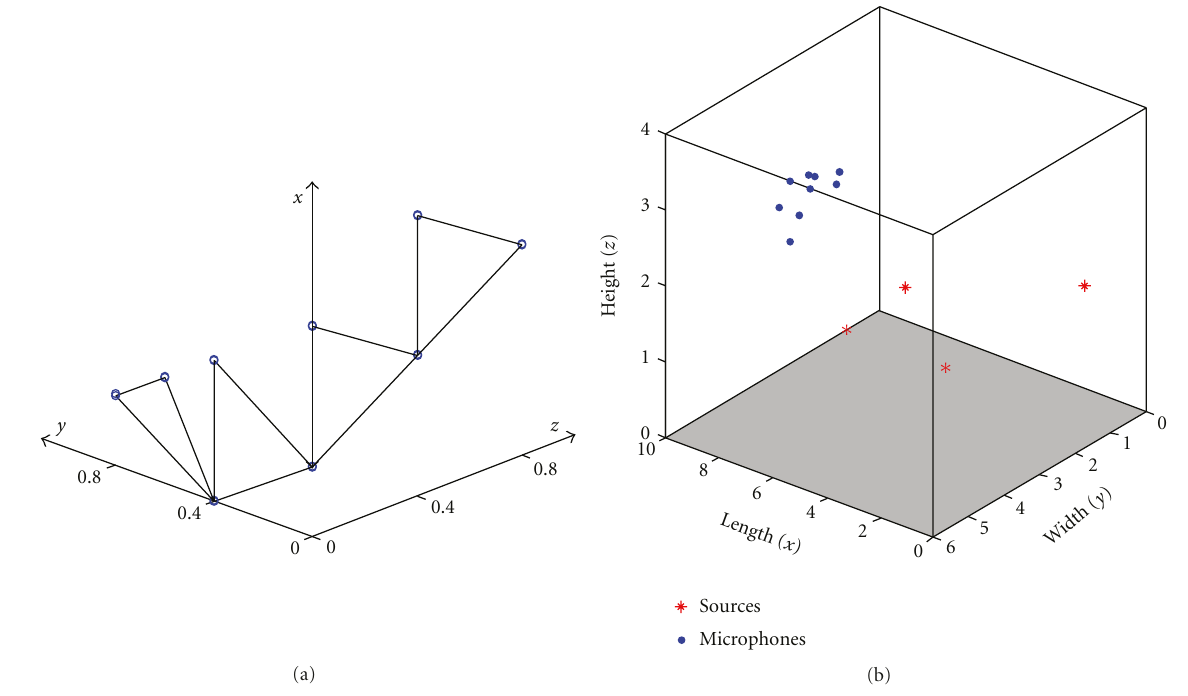
Figure 2: (a) Triangular-shape microphone array. (b) Schematic representation of the simulated room. Table 1: Comparison between 3D RMSE of various speech source localization methods on artificially generated data.